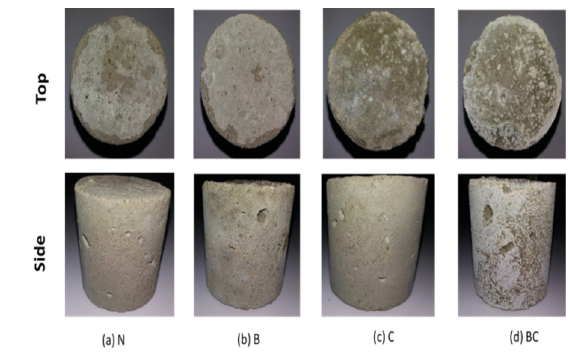
Fig. 8: Samples after Fourteen Days of Curing 3.4 Comparison of N, B, C and BC Samples on 22 nd Day of Curing Fig. 9(a-d) indicate that no change in morphology were observed in N, B and C samples but for BC sample which again showed a much more increase in the surface layer with white dotted appearance that indicated the healing of micro-cracks and voids is continued even after 22 days of curing.